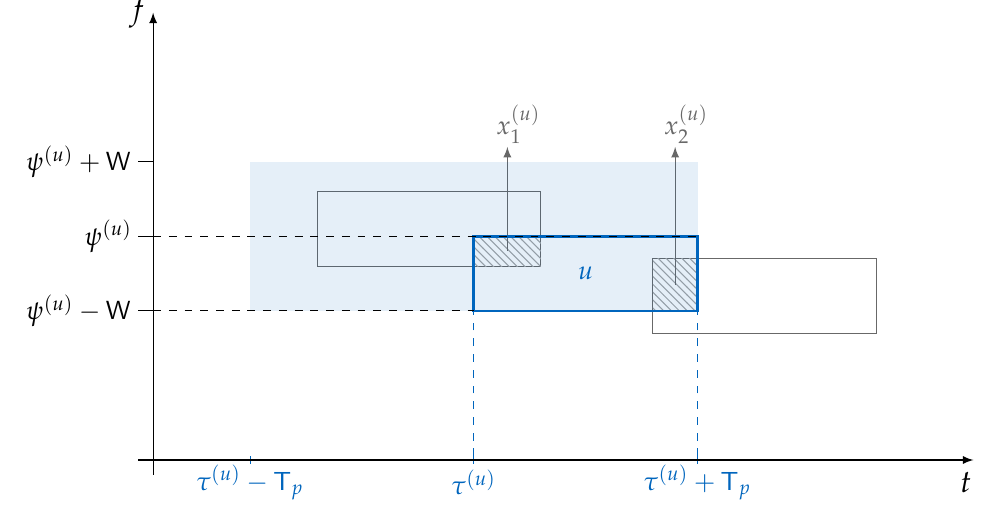
Figure 2. Time and frequency ALOHA, example of a collision with two other packets, i.e., j = 2. In = x ( u ) + x ( u ) = x ( u ) this case we have X ( u ) , X ( u ) , and ˆ Z ( u ) = x ( u ) . In general, the start of any packet 2 2 2 1 1 1 (cid:16) (cid:17) (cid:16) (cid:17) T p , τ ( u ) + T p W , ψ ( u ) + W τ ( u ) ψ ( u ) in the range and , represented by the shaded blue area, − − would cause a collision with the data unit of user u